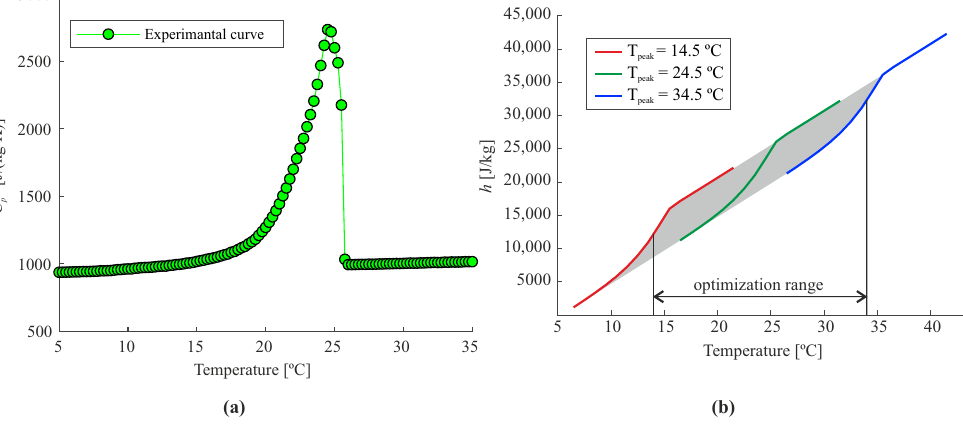
Figure 3. MPCM-based cementitious composite: ( a ) Experimental c p − T curve obtained in [38]; ( b ) Enthalpy curve model and the shift range allowed for the T peak